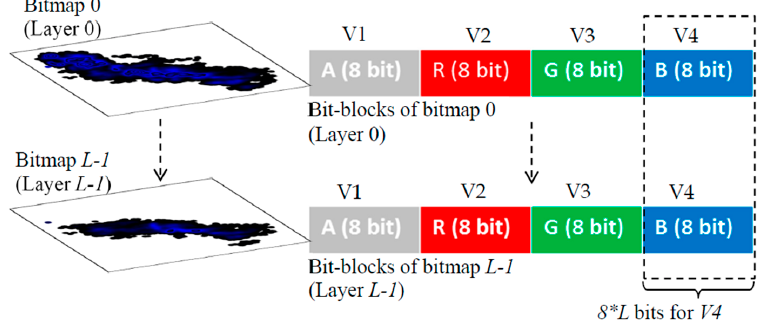
Figure 3. Four variables (V1, V2, V3 and V4) are represented using multiple bitmaps of a 32-bit RGB pixel format for forming a multi-variable multi-layer graphical knowledge unit (MVML-GKU). Each pixel is divided into four equal portions, where each portion consists of eight bits. When the 32-bit RGB pixel format is divided into four equal parts, each variable represents the alpha, red, green and blue sections of the pixel. This provides a vertical array of k ˆ L bits for one